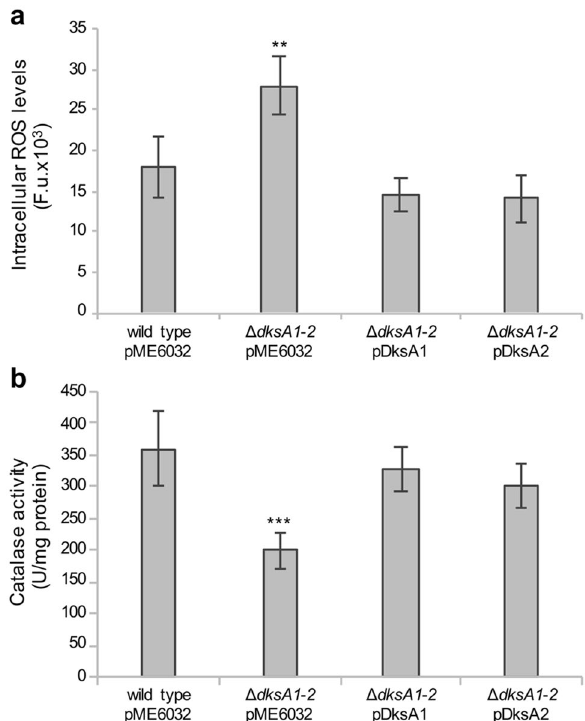
Figure 4. Effect of dksA1 and dksA2 on endogenous ROS levels and catalase activity. Intracellular levels of ROS (expressed as Fluorescence Units, F. u.) ( a ) and catalase activity ( b ) were determined in the indicated strains grown to the late exponential phase (OD 600 ≈ 2.5) in LB supplemented with 0.1 mM IPTG. The average values from three independent experiments are reported with standard deviations. ** p < 0.01, *** p < 0.001 versus wild type